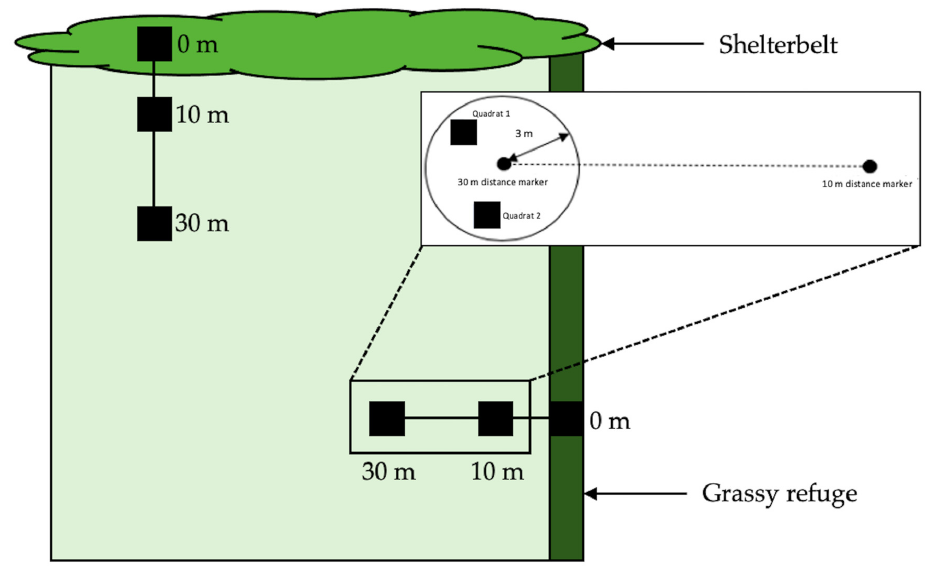
Figure 2. The arrangement of collection points at a field (NB, not to scale). Inset: Experimental set up for direct searching (quadrat 1) and vacuum sampling (quadrat 2), as undertaken in